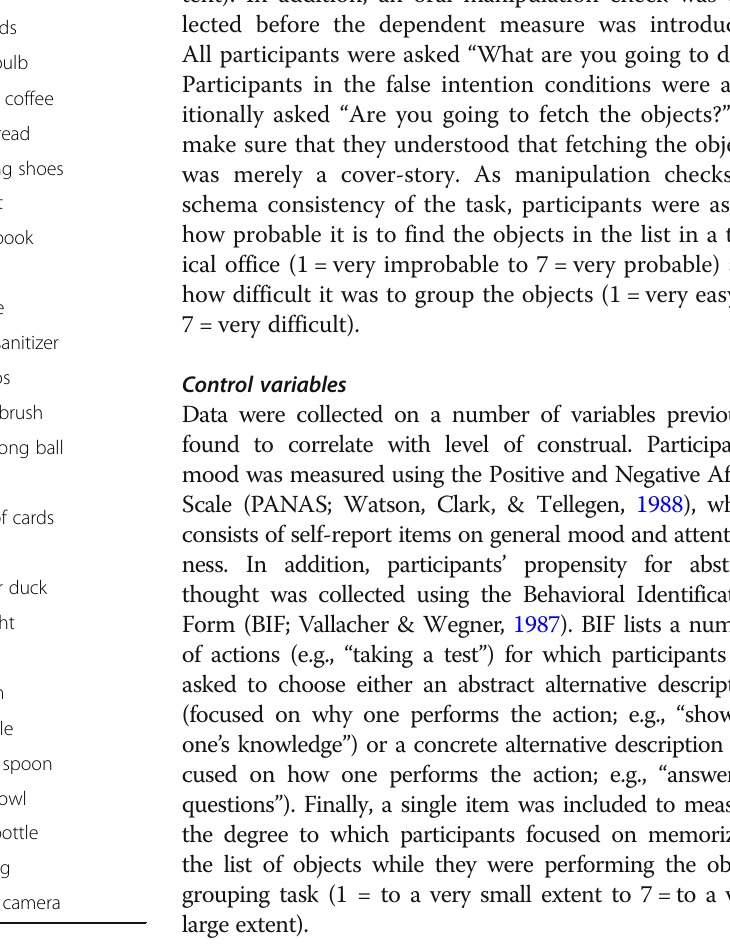
Table 1 Objects used for the dependent measure Schema-consistent task condition